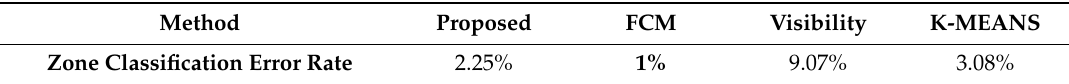
Table 1. Zone classification error rate